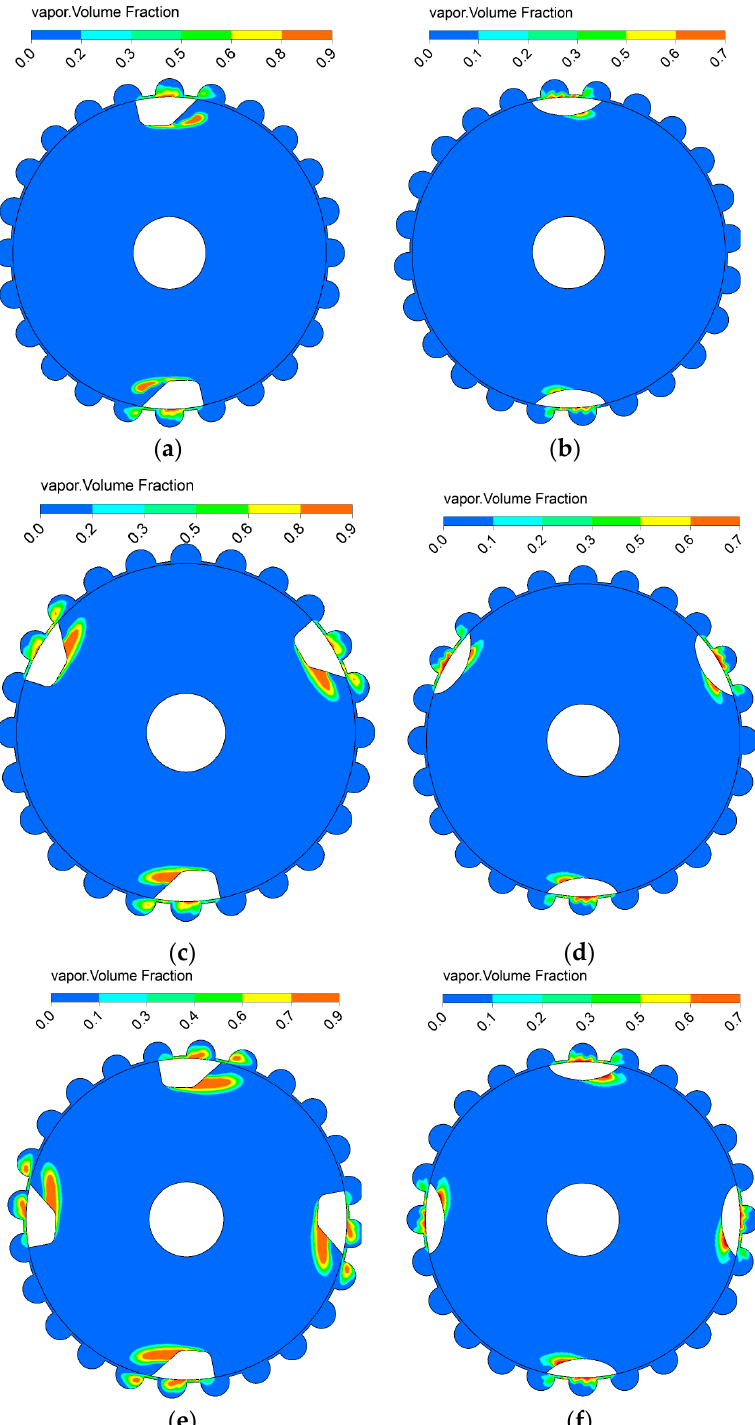
Figure 19. Cavitation compared different number of streamlined cutter head with non-streamlined. ( a ) non-streamlined 2 cutter head, ( b ) streamlined 2 cutter head, ( c ) non-streamlined 3 cutter head, ( d ) streamlined 3 cutter head, ( e ) non-streamlined 4 cutter head, ( f ) streamlined 4 cutter head.